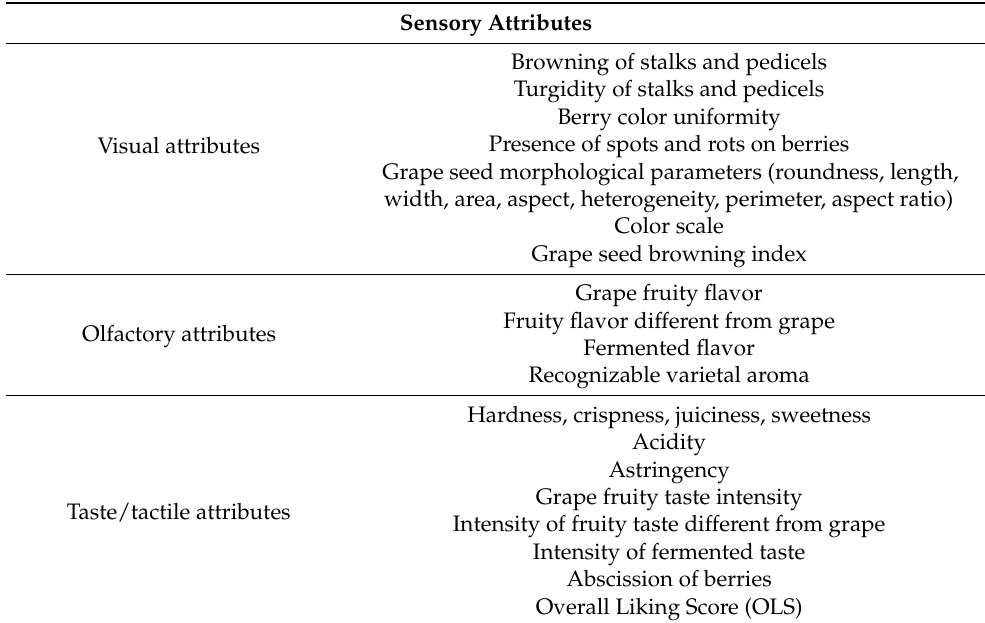
Table 3. List of sensory attributes used as maturity